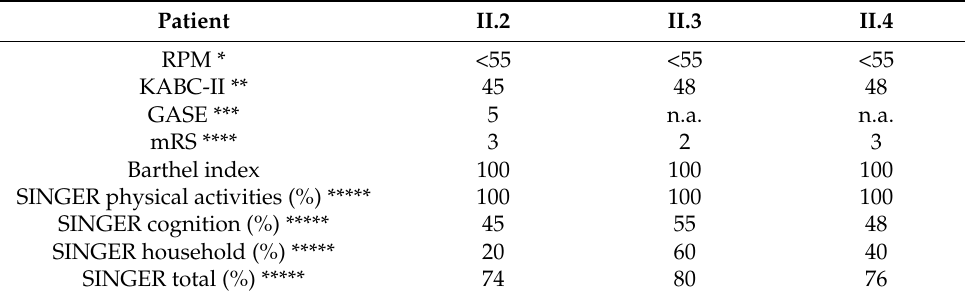
Table 1. Cognitive and disability assessment by rating scales.